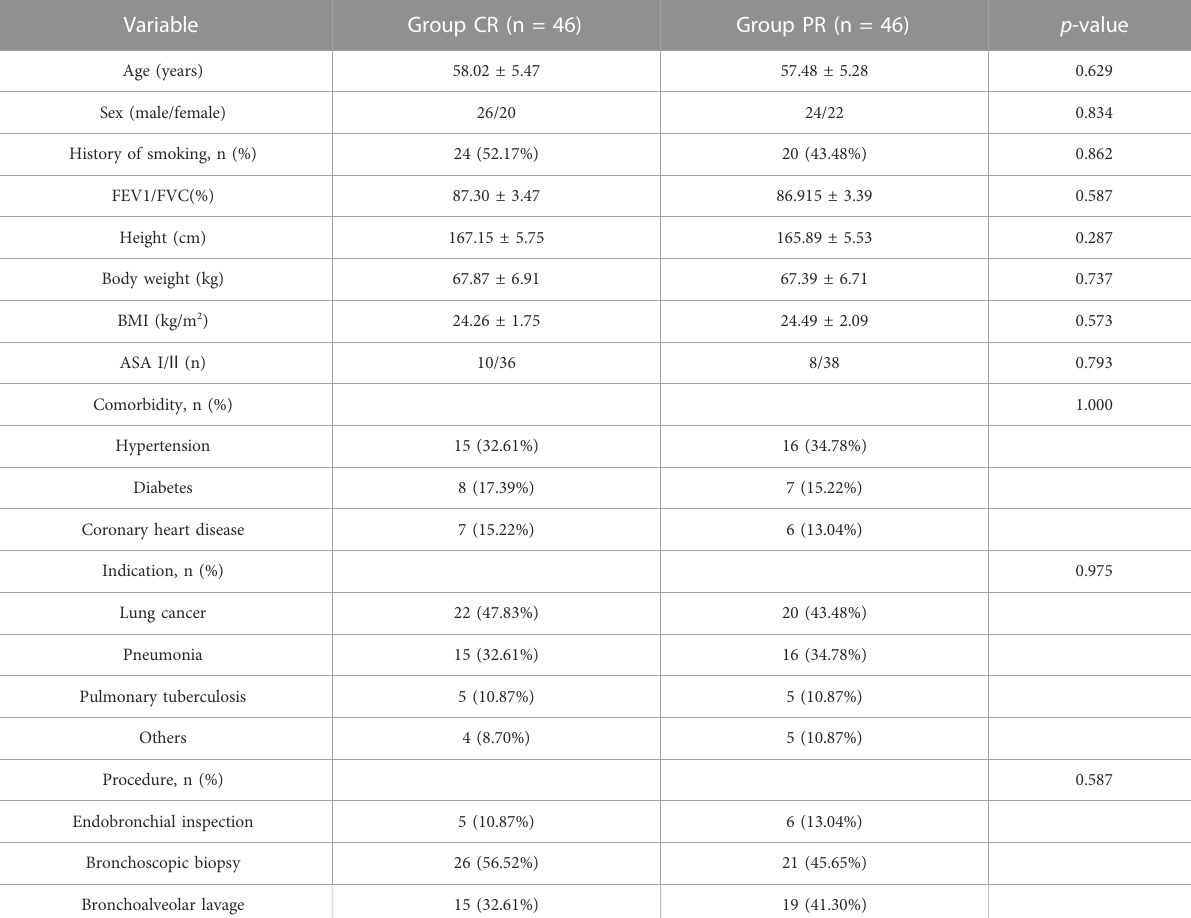
TABLE 1 Demographic characteristics between the two groups.